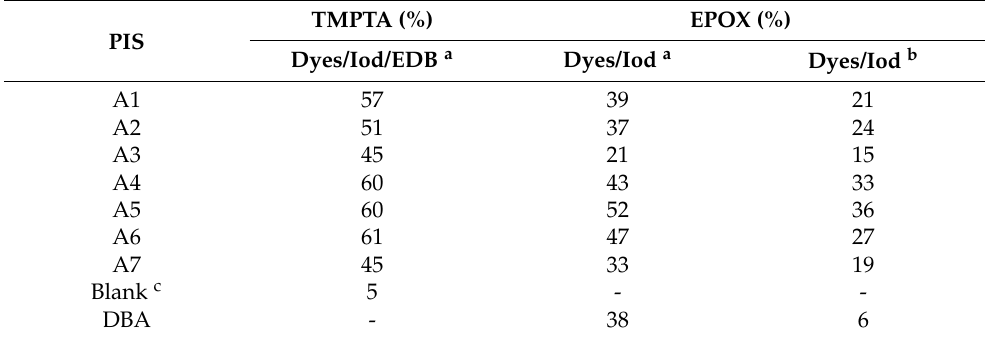
Table 6. TMPTA and EPOX conversions obtained with the three-component